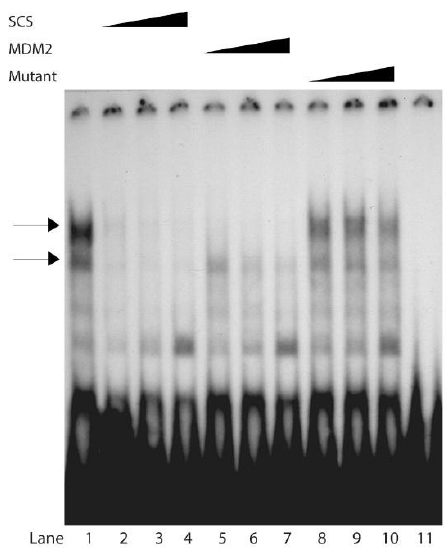
Figure 2. Competitive binding of the SCS-protein complexes with varying excesses of different oligonucleotides containing p53 binding sites. EMSAs in lanes 1–10 contained 4 μg of protein extract and 0.5 pmole of radiolabeled SCS. Lane 1: no competitor. Lanes 2–4: binding in the presence of excess non-radiolabeled SCS oligonucleotide. Lanes 5–7: binding in the presence of the natural p53 binding site from the MDM2 gene. Lanes 8–10: binding in the presence of the mutant RGC (mtRGC) oligonucleotide. Competition was carried out with 40 fold (lanes 2, 5 and 8), 80 fold (lanes 3, 6, and 9), and 160 fold (lanes 4, 7, and 10) excesses of oligonucleotides. The two bands that are responsive to the competition are indicated by the two arrows. Lane 11 contains 0.5 pmole of radiolabeled SCS without protein or competitor. To increase resolving power, this gel was run until the bromophenol blue reached the bottom.